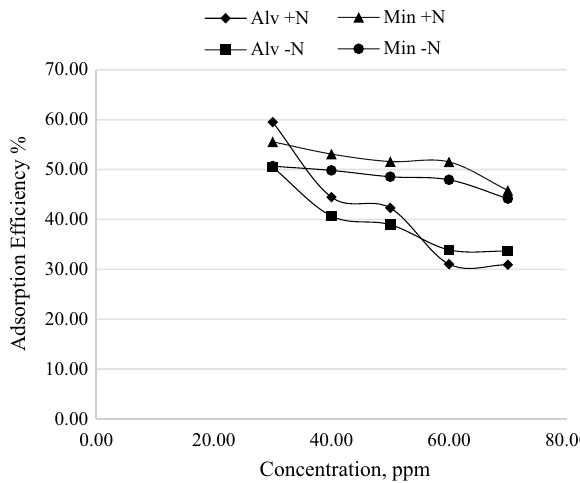
Fig. 1 Effect of initial ion concentration on the adsorption efficiency of Pb 2+ onto N. alveolaris + N, N. alveolaris –N, N. minuta + N, and N/ minuta –N algae